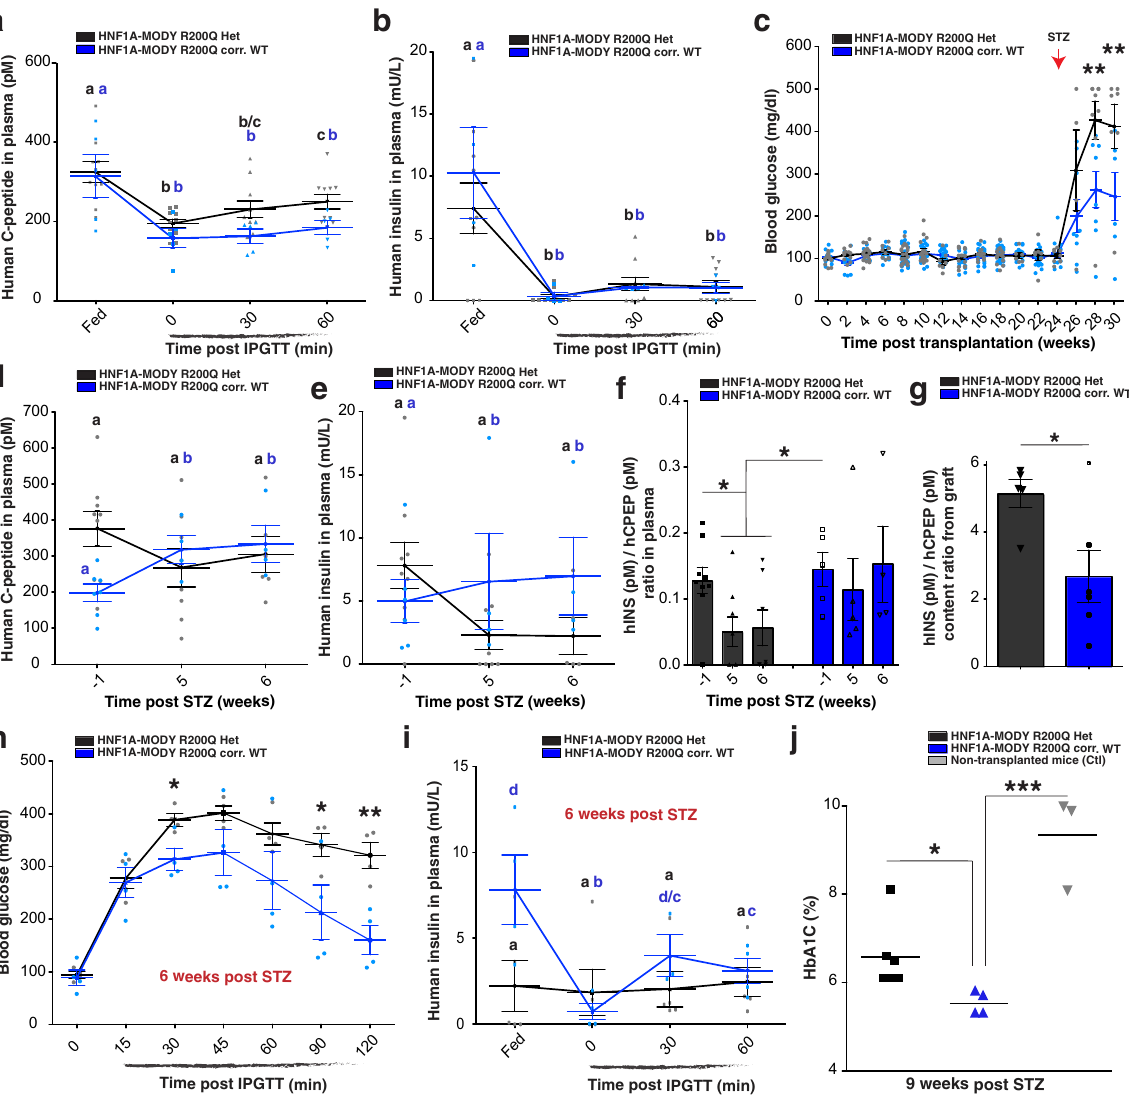
Fig. 6 HNF1A haploinsuf fi ciency gradually impairs sc β -cell function in vivo. a – c Human C-peptide (pM) and human insulin levels in plasma of ad libitum- fed mice transplanted with HNF1A-MODY iPSC-derived endocrine cells ( HNF1A + /R200Q and R200Q-corrected WT). a Plasma human C-peptide (pM) and b human insulin secretion (mU/L) in mice transplanted with HNF1A-MODY iPSC-derived endocrine cells (R200Q Het n = 10 and R200Q corr. WT n = 5) in ad libitum-fed state and during an iPGTT (t0, t30, and t60). p -values were b : p < 0.001, b , c : p < 0.01 and c : p < 0.05. c Blood glucose concentrations (mg / dl) in ad libitum-fed mice transplanted with HNF1A-MODY iPSC-derived endocrine cells (R200Q Het n = 21 and R200Q corr. WT n = 32). Mice (R200Q Het n = 8, R200Q corr. WT n = 8 and Ctl n = 5) were injected (red arrow) with STZ. d Human C-peptide (pM), e human insulin (mU/L) (R200Q Het n = 9 and R200Q corr. WT n = 6), and f hINS (pM)/hCPEP (pM) secretion ratios monitored in plasma of ad libitum-fed mice weeks before ( − 1) and after (5 and 6) STZ treatment. p -values were b , d : p < 0.01; c: p < 0.05. g Quanti fi cation of hINS(pM)/hCPEP(pM) content ratios from isolated grafts. h , i IPGTT in mice transplanted with HNF1A-MODY iPSC-derived endocrine cells (R200Q Het n = 5 and R200Q corr. WT n = 4) 6 weeks post STZ treatment in ad libitum - fed state and during an iPGTT (t0, t30 and t60). h Blood glucose concentrations (mg/dl) and i human insulin secretion (mU/L) in plasma. p -values were b p < 0.01, d / c and c : p < 0.05. (R200Q Het n = 5 and R200Q corr. WT n = 4). j HbA1C (%) in mice transplanted with HNF1A-MODY -iPSC-derived endocrine cells or non-transplanted (Ctl) 9 weeks after STZ treatment. All mice were transplanted with iPSC-derived endocrine cells at day 27 of differentiation, and grafts were isolated 30 – 35 weeks post-transplantation for ex vivo analysis. All protein concentrations were measured by ELISA. For scatter plots, each point in the plot represents an independent biological experiment ( n ). Data are represented as mean ± SEM. Different letters designate signi fi cant differences within groups. p -values were * p < 0.05, ** p < 0.01, *** p < 0.001; two-tailed t -test. n.s. non-signi fi cant. See also Figs. S11 – (R200Q/R200Q), con fi rming the pathogenicity of the R200Q in the treatment of HNF1A-MODY. However, HNF1A de fi ciency allele. The de fi ciency in insulin secretion can be overcome has pleiotropic effects, which will need to be further elucidated for through the application of sulfonylureas, by increasing the effective treatment long term. The triggering of insulin release low calcium levels found in HNF1A mutant cells. Thereby we through sulfonylureas often becomes insuf fi cient at later stages of demonstrate the molecular basis for the ef fi cacy of sulfonylureas the disease.